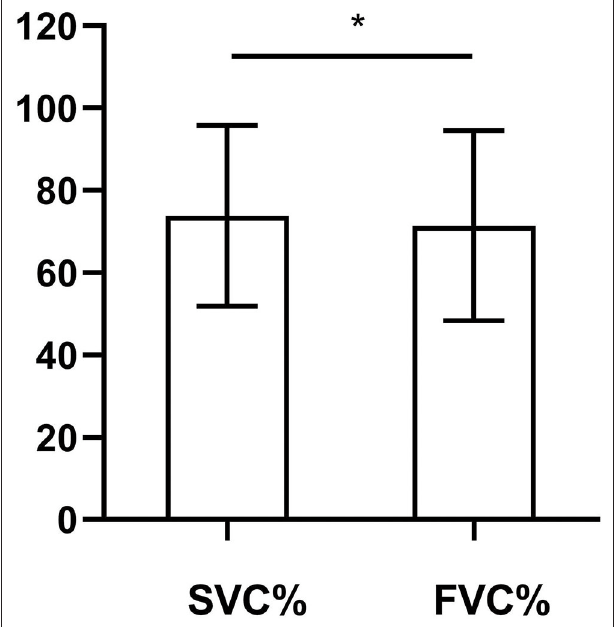
FIGURE 2 | Comparison of SVC% and FVC% in bulbar-involved ALS ( n = 51). SVC% (73.82 ± 21.95) was significantly higher than FVC% (71.42 ± 23.15). SMD = 0.51. p = 0.013. SVC%, percent predicted SVC values; FVC%, percent predicted FVC values; ALS, amyotrophic lateral sclerosis; SMD, standardized mean difference. * p <